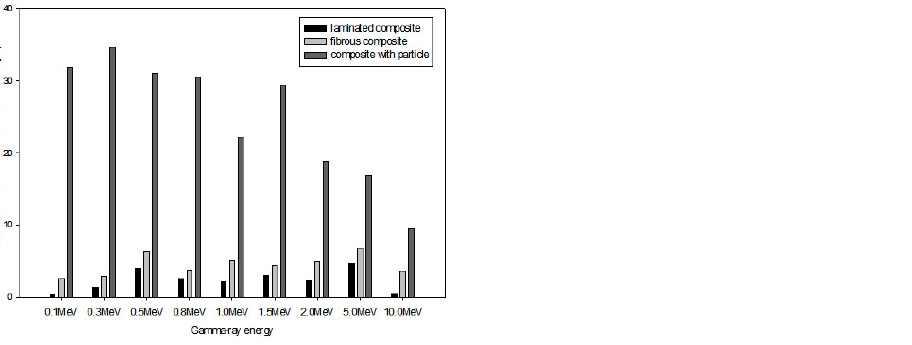
Figure 14. Rate of increase of linear attenuation coefficient caused by structural change of PE/copper composite.